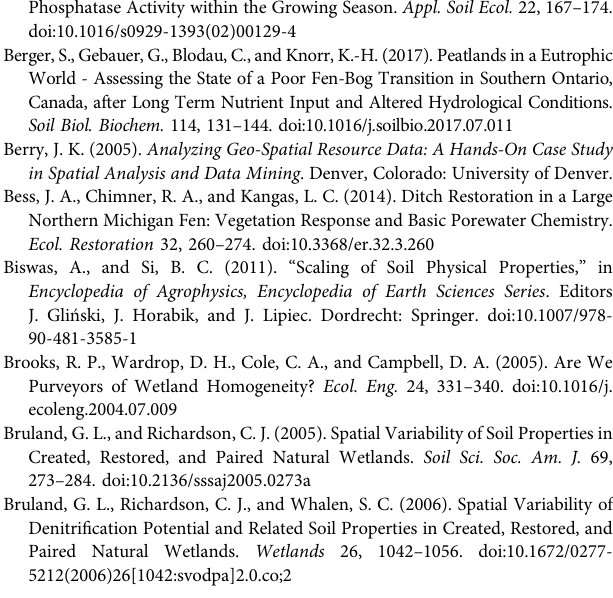
Frontiers in Environmental Science |